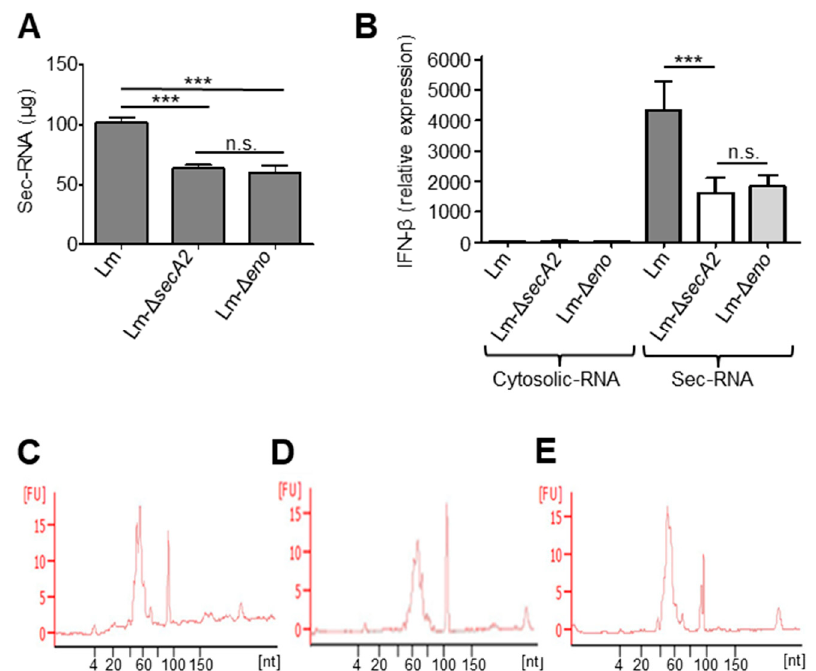
Figure 7. ( A ) Reduced amount of secreted RNA (sec-RNA) in the supernatant of Lm- ∆ secA 2 and Lm- ∆ eno as compared to wild type (Lm); ( B ) IFN- β induction capability of cytosolic RNA and sec- RNA isolated from Lm, Lm- ∆ secA 2 and Lm- Δ eno . No significant differences were detectable for